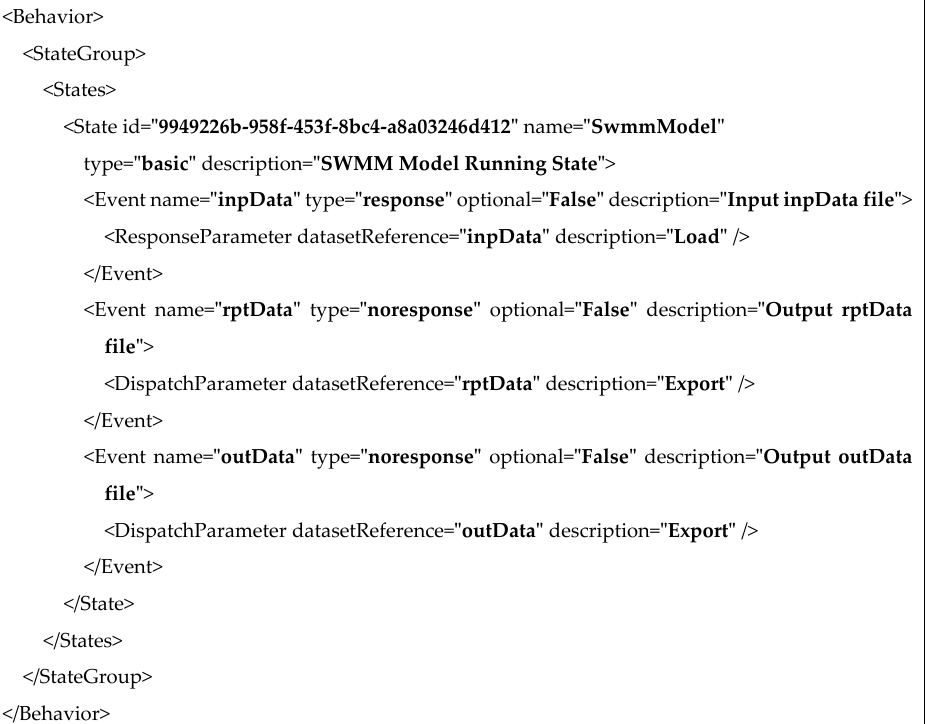
Figure 6. Description of the model deployment interface in the MDL. After the description and encapsulation of the model are completed, the dependency folder (assembly), encapsulation folder (model), support folder (supportive), and test folder (testify) are packaged into a model deployment package. The dependency folder generally contains model-encapsulated dependencies (SWMM just involve a simple dependency (swmm5.dll), so this dependency is put in the encapsulation folder, and the assembly folder is